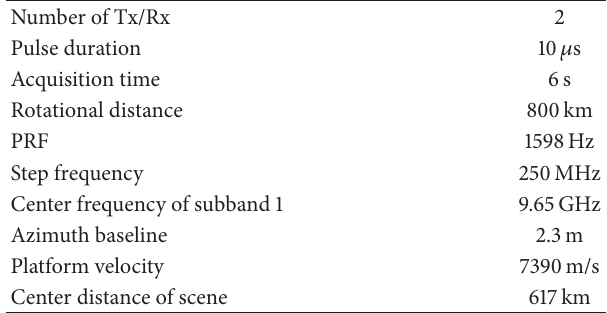
Table 1: Main system parameters of point target